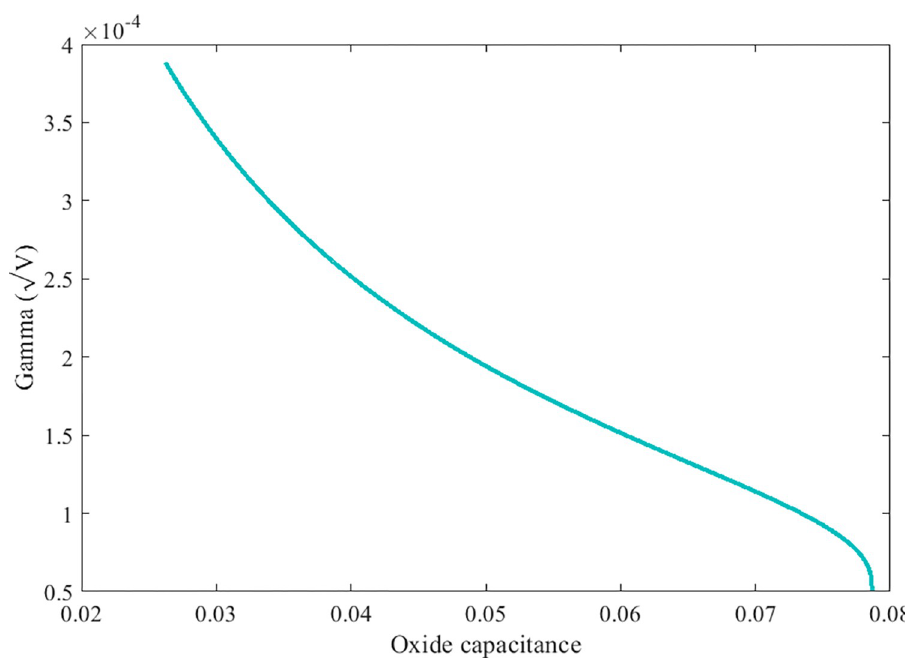
Fig 5. Variation in body bias coefficient by varying oxide